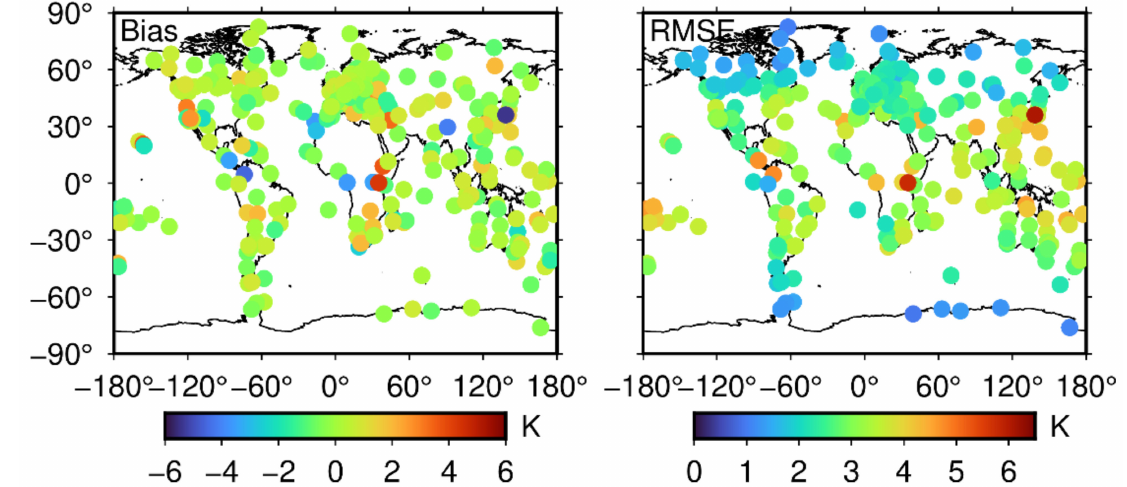
Figure 5. Error distribution map of the SH_set data compared to the global IGS stations in 2018. The left side of the picture is the Bias distribution diagram, and the right side is the RMSE distribution